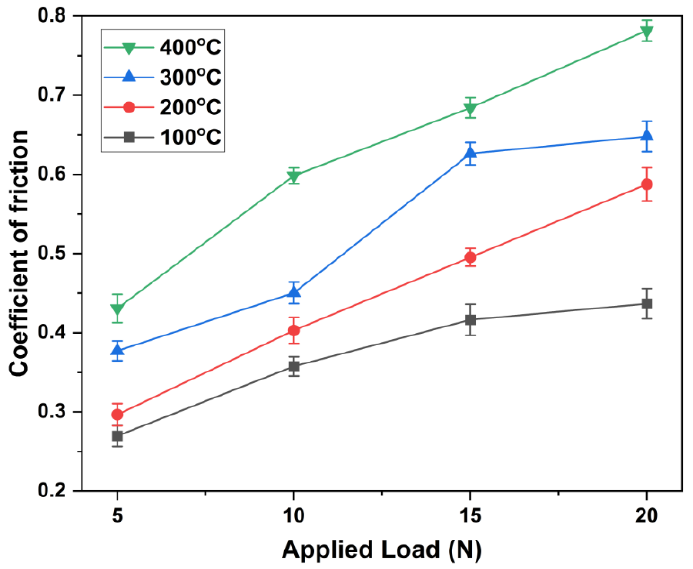
Figure 10. Effect of applied load on coefficient of friction at different temperature for Al–CNT-Sn specimens with 1.0 wt. % CNT.